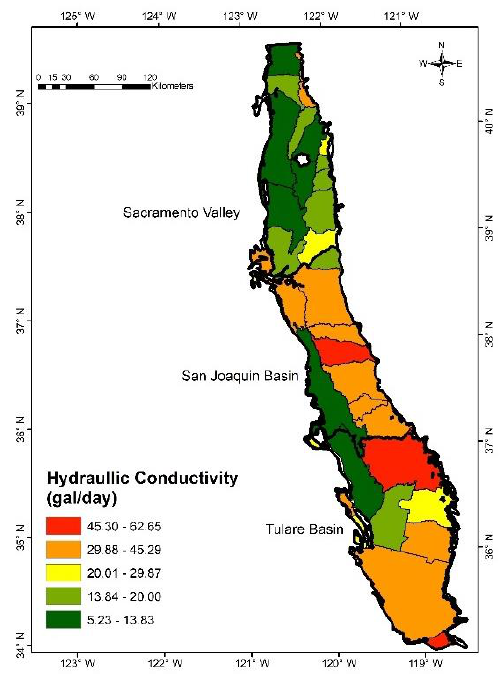
Figure 9. Impact of Vadose Zone in Central Valley